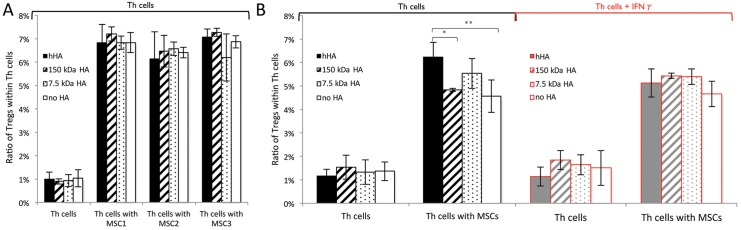
Effect of different MWs of HA on the MSC-mediated induction of Tregs.Frequency of Tregs (CD25+CD127-) within CD4+ T cells is shown (A, B). A) Effect of MSC donor-to-donor variability and different MWs of HA on Treg frequency. B) Effect of IFNγ-supplemented conditions on the Treg ratio from CD4+ T cells when MSCs and/or HAs are present. (A) and (B) show data from two separate experiments; normal conditions are shown in (B) for comparison purposes with IFNγ- supplemented conditions. Solid filled bars stand for hHA; hatched bars, 150 kDa HA; dotted bars, 7.5 kDa HA and empty bars, no HA. Black color, normal conditions and gray color with red frame, IFNγ-supplemented conditions. Each bar indicates the mean of triplicates replicates from MSCs or Th cell from one donor. Error bars represent 95% CI. * p<0.05, ** p<0.01 and ***<0.001.